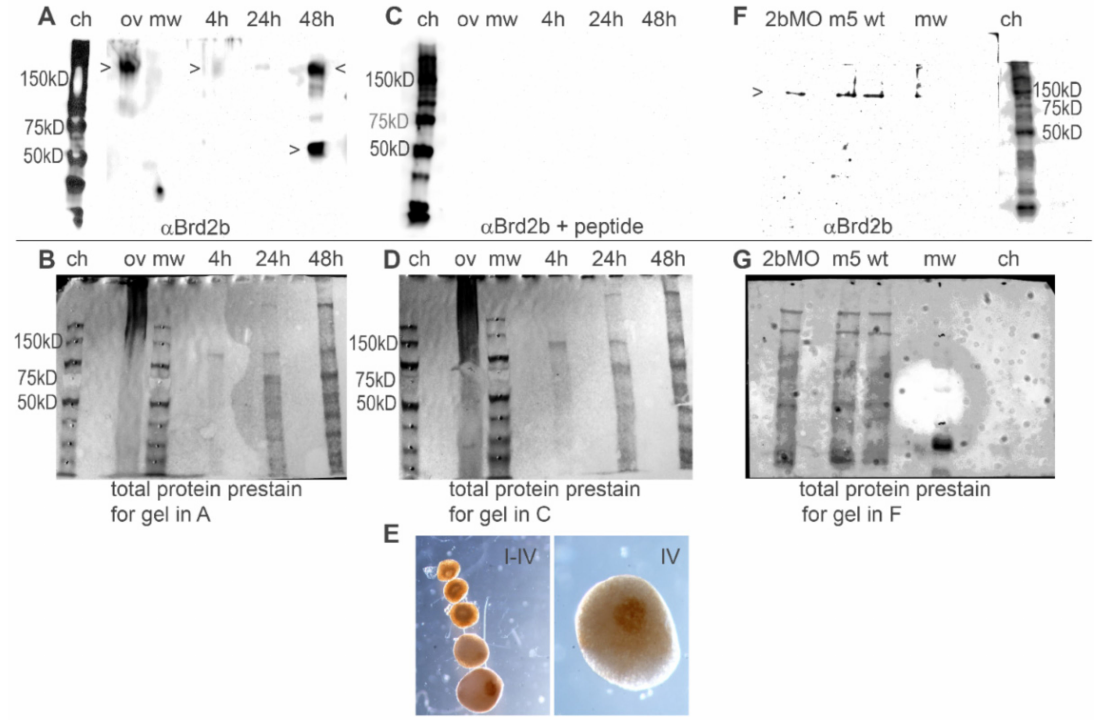
Figure 2. Anti-Brd2b peptide antibody detects major protein products in zebrafish embryos and oocytes, that are reduced in brd2b MO morphants. ( A , B ) Western blot ( A ) of total ovary (ov) and staged embryos (4 h, 24 h, 48 h) probed with anti-Brd2b peptide antibody. Blot was prestained ( B ) to assess total protein and relative loading across lanes. Total ovary samples often show a large amount of high molecular weight staining corresponding to yolk proteins that make up predominant products in this tissue; nevertheless, these do not interfere with the detection of Brd2b. A product over 150 kD is consistently detected in ovaries and 48 hpf embryos and sometimes faintly in 4 and 24 hpf embryos (top arrowheads in A); a product between 50 and 75 kD is also consistently detected in 48 hpf embryos (bottom arrowhead) and sometimes also in 4 hpf and 24 hpf embryos (see Supplementary Figure S1). ( C , D ) Duplicate blot of A probed with anti-Brd2b peptide antibody in the presence of peptide antigen for peptide competition assay ( C ). The blot was prestained ( D ) to assess total protein and relative loading across lanes before antibody + peptide incubation. Peptide competition prevents all antibody signals on blot ( C ), supporting specificity of antibody for Brd2b epitope. Prestaining of blot using Memcode protein stain ( D ) assures that lack of anti-Brd2b signal in C is due to peptide competition rather than lack of protein in lanes. ( E ) Immunohistochemical analysis of staged oocytes (I–IV) and higher magnification stage IV oocyte (IV) using anti-Brd2b peptide antibodies, and showing eventual localization to the micropyle and future animal pole. ( F , G ) Western blot to assess efficacy of brd2b MO morpholino knockdown. Twenty-four hours post-fertilization embryo treatment groups: uninjected (wt), control 5-base mismatch morpholino-injected (mis5), and brd2b MO1-injected (2bMO), probed with anti-Brd2b peptide antibody ( F ). The blot was prestained ( G ) to assess total loading and relative loading across lanes. When relative loading is taken into account, there is a 3-fold reduction in Brd2b (~150 kD band) in brd2b MO-treated embryos (2ng total) as measured by ImageJ (FiJI) using band pixel densities (see Methods). Anti-Brd2B peptide antibody used in all immunoblot experiments in this study was raised against an antigenic epitope between NLS and ET (see Materials and Methods), and detects only the long isoform (Brd2b-L). Bottom edges of Western blots are indicated by horizontal line in ( A , C and F ). mw = Precision plus dual color molecular weight standard (BioRad); ch = Precision plus Western Chemiluminescent marker